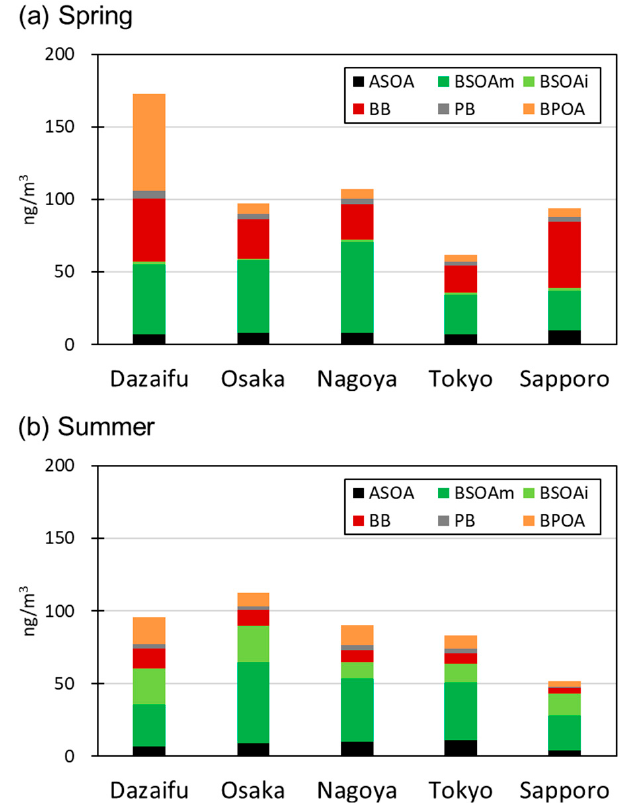
Figure 2. Chemical composition of the organic tracers detected in the PM 2.5 collected at each site. Six categorized groups are shown (anthropogenic secondary aerosol (ASOA), monoterpene-derived SOA (BSOAm), isoprene-derived SOA (BSOAi), biomass burning (BB), plastic burning (PB), and primary biogenic organic aerosol (BPOA)).